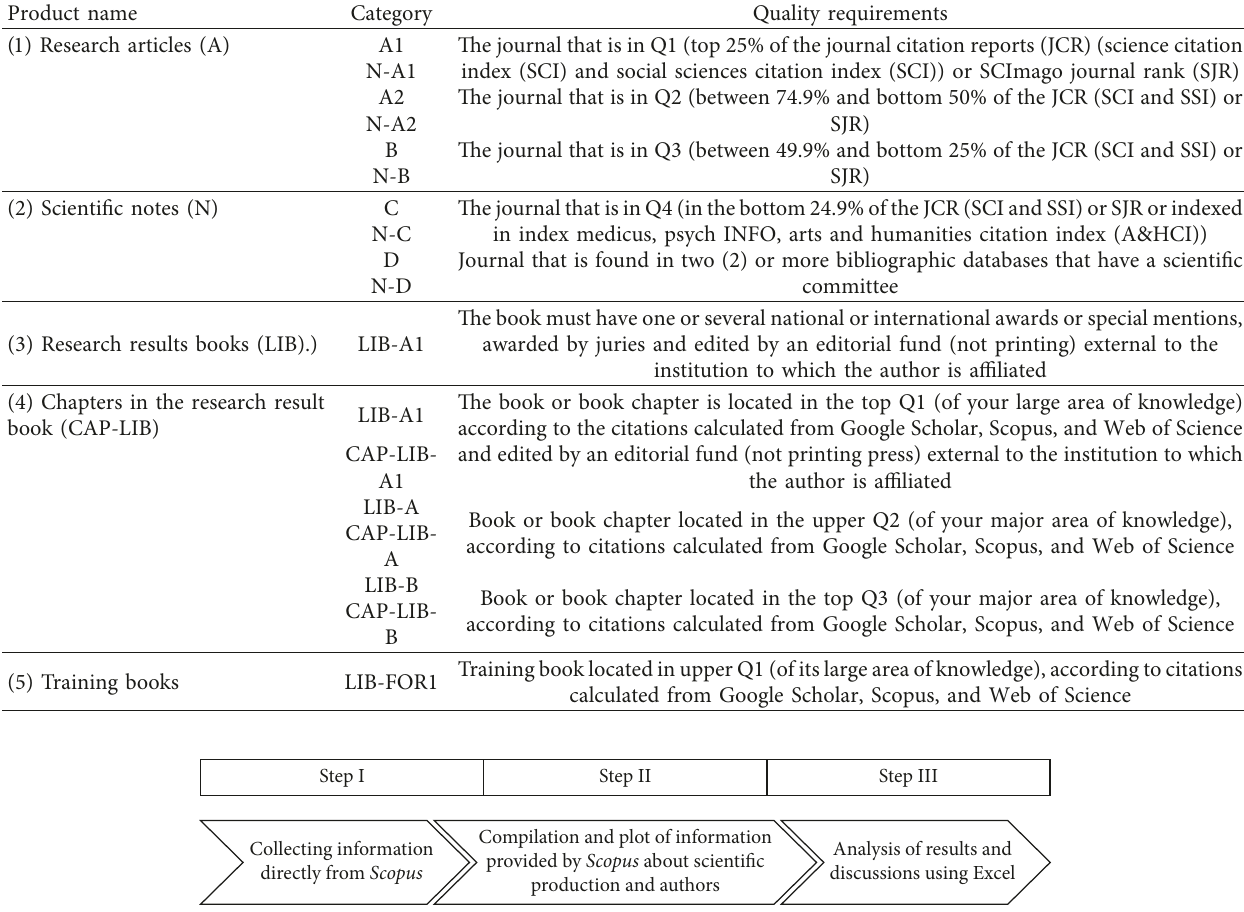
Table 1: Typologies of scientific production of groups and researchers in Colombia.